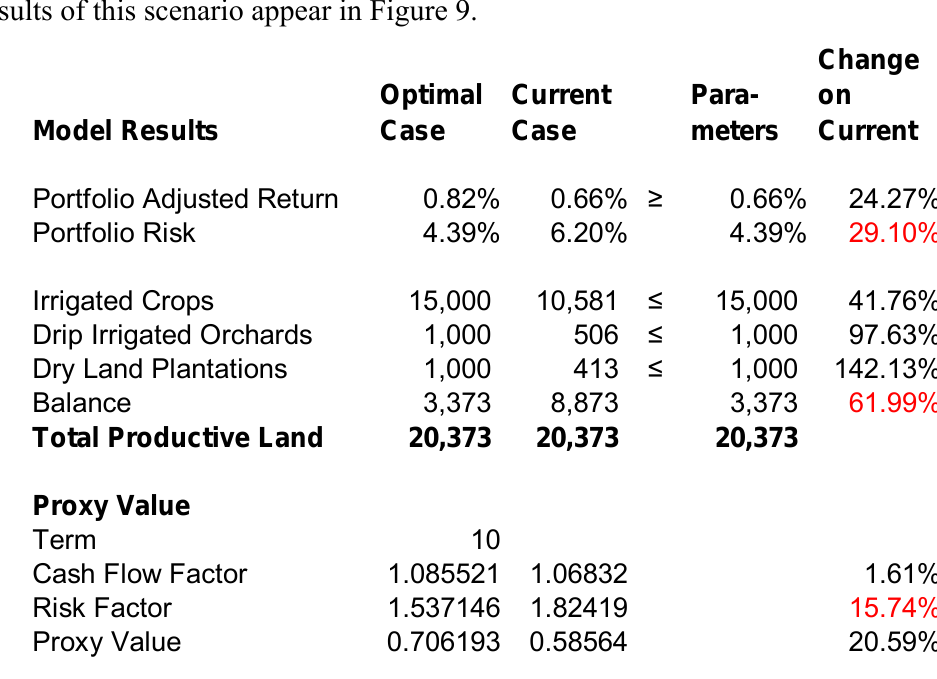
Figure 9 - Optimised solution at Position